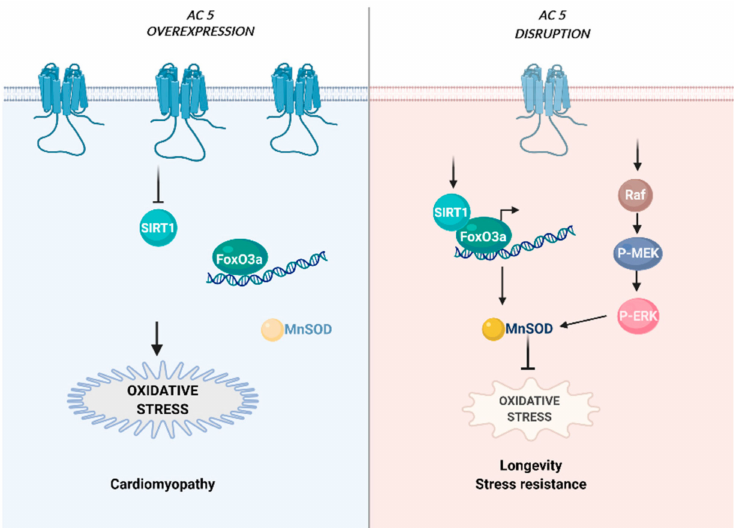
Figure 2. Schematic representation of the main AC5-driven pathways in ageing. ( left panel ): AC5 overexpression leads to enhanced oxidative stress through the SIRT1/FoxO3a axis. Conversely, dis- ruption of AC5 leads to beneficial effects through the SIRT1/FoxO3 activity and the Raf/MEK/ERK signalling cascade, both impinging on the MnSOD levels ( right panel ). Created with